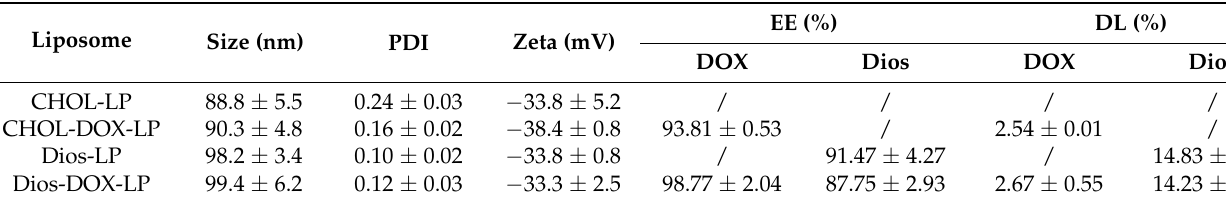
Table 2. Comparison of particle size, PDI, Zeta, EE and DL between CHOL-LP, CHOL-DOX-LP, Dios-LP and Dios-DOX-LP.